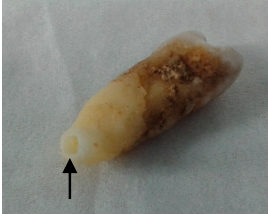
Figure 2. Photo of the tooth extracted from the achondroplastic skeleton . Powder from the premolar tooth was obtained by drilling into the tooth from the tip of the root (black